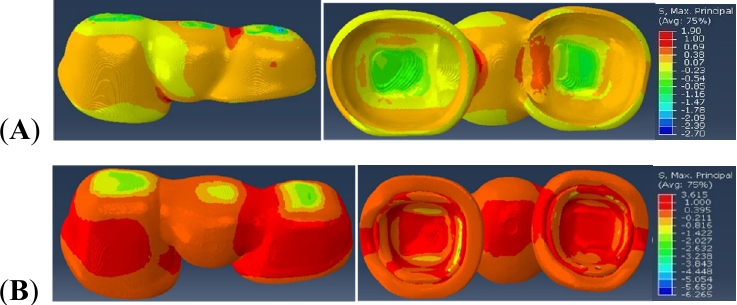
Figure 4. Stress distribution in the ( A ) Veneer and ( B ) Framework region of Model B.